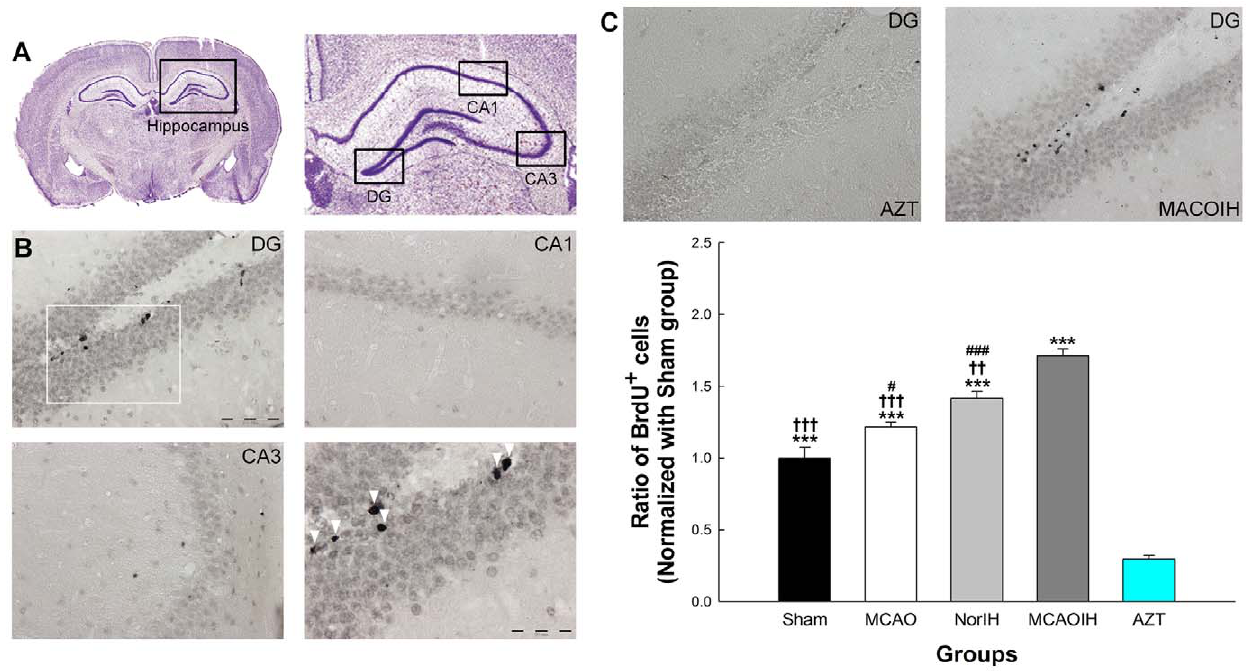
Figure 2. Post-ischemia IH intervention induced hippocampal neurogenesis. (A) Schematic depicting hippocampal subregions of interest. (B) BrdU + cells in each hippocampal subregion (bar, 100 m m). The lower right image is a 40 6 magnification of the region boxed in white (bar, 50 m m). BrdU + cells are indicated by arrows. BrdU + cells were expressed primarily in the DG. (C, top) BrdU staining in the AZT group as compared to the MCAOIH group. (C, bottom) Quantification of BrdU staining. * p , 0.05, ** p , 0.01, *** p , 0.001, compared to the AZT group. {{ p , 0.01, {{{ p , 0.001, compared to the MCAOIH group. # p , 0.05, ### p , 0.001, compared to the Sham group.